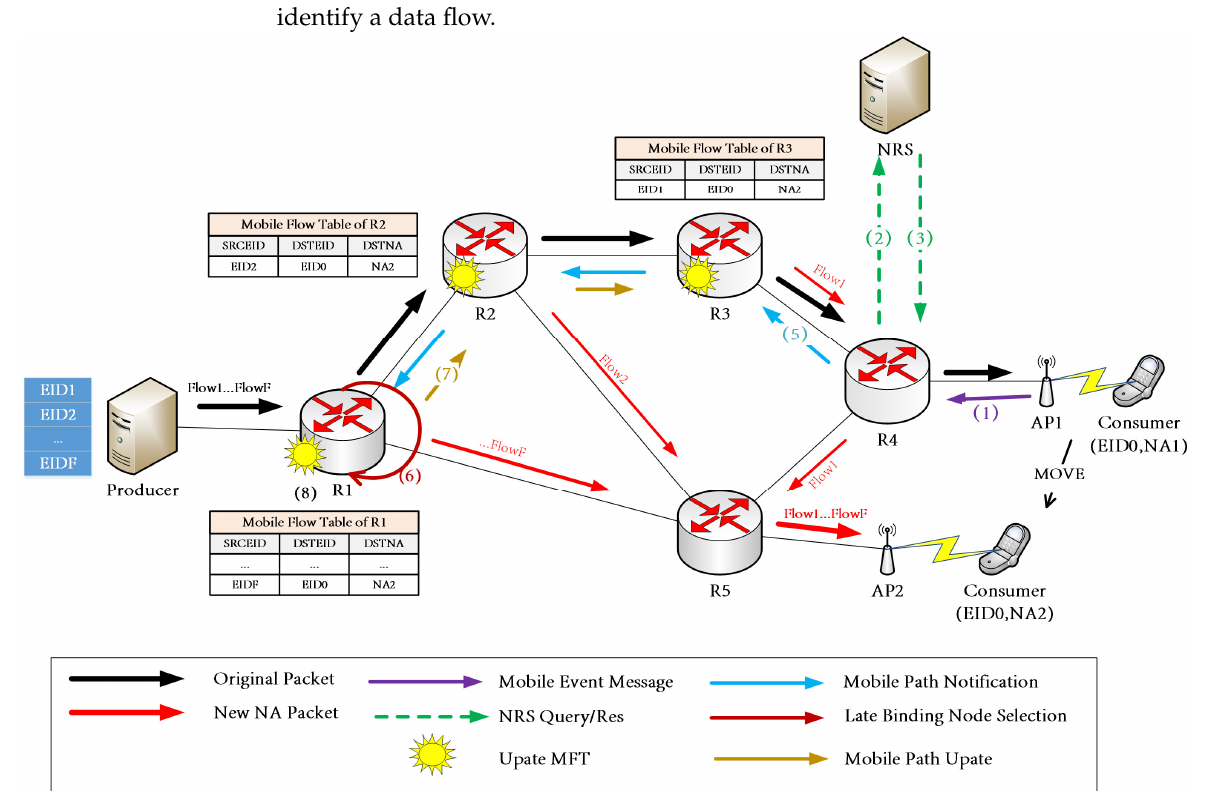
Figure 1. Architecture and handoff for dynamic allocation of mobile data flows.